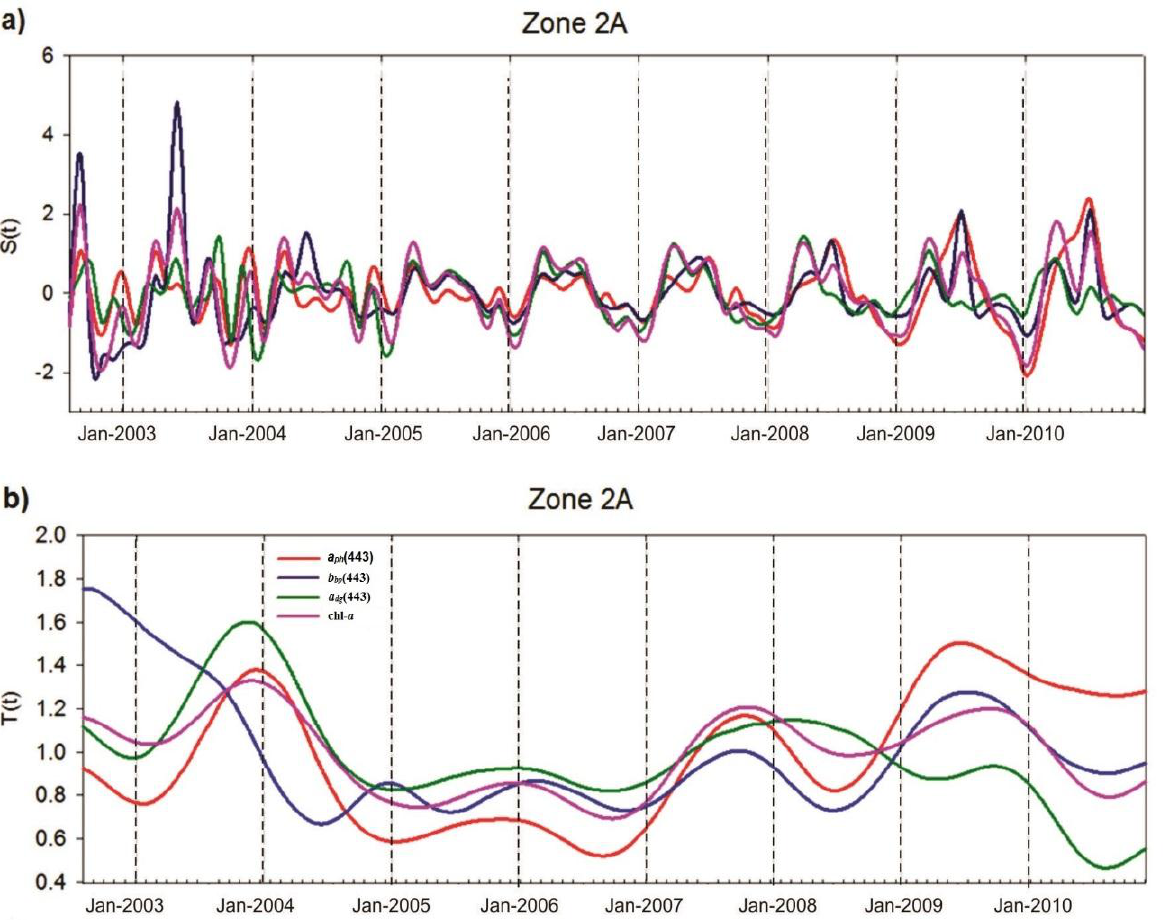
Figure 9. X-11 terms statistics of a ph (443) , b bp (443) , a dg (443), and chl- a in the zone of interest 2A. ( a ) S(t) (seasonal term); ( b ) T(t) trend term. (3)